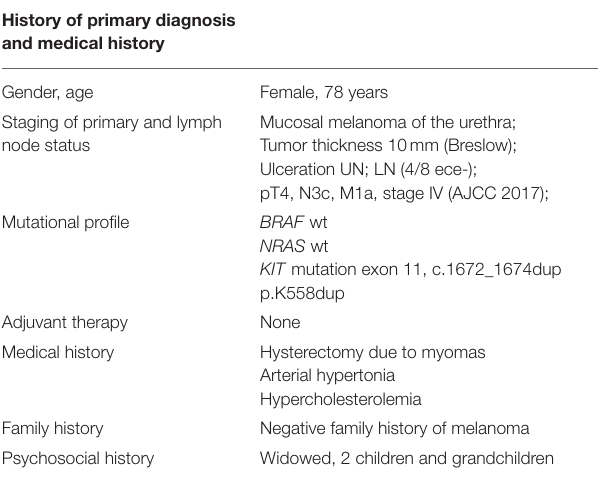
TABLE 1 | Medical history, clinical, histological, and molecular characteristic of the